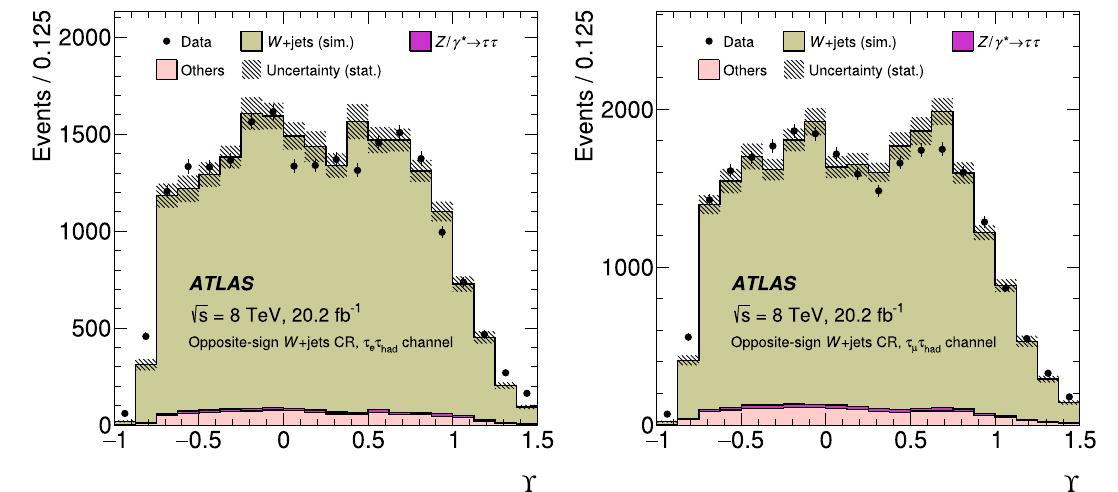
from the simulation. The shape of the W +jets contribution is estimated from the simulation as well. The W +jets contribution is normalised such that the total estimated event yield matches the observed yield. Only statistical uncertainties are